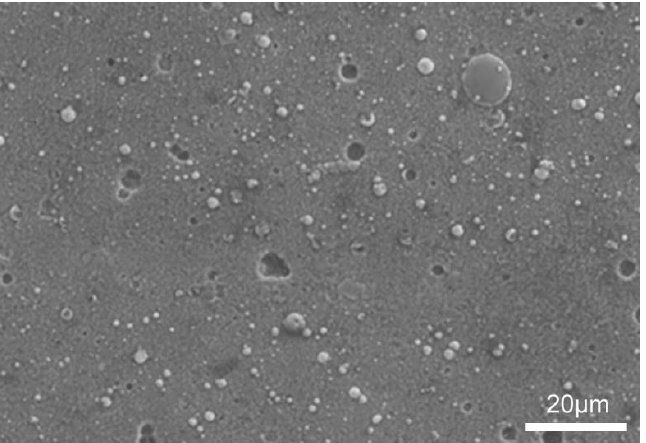
Figure 3. Surface morphology of the composite TiN2Ti1Al10 titanium nitride layer on magnesium AZ91D alloy — general view.